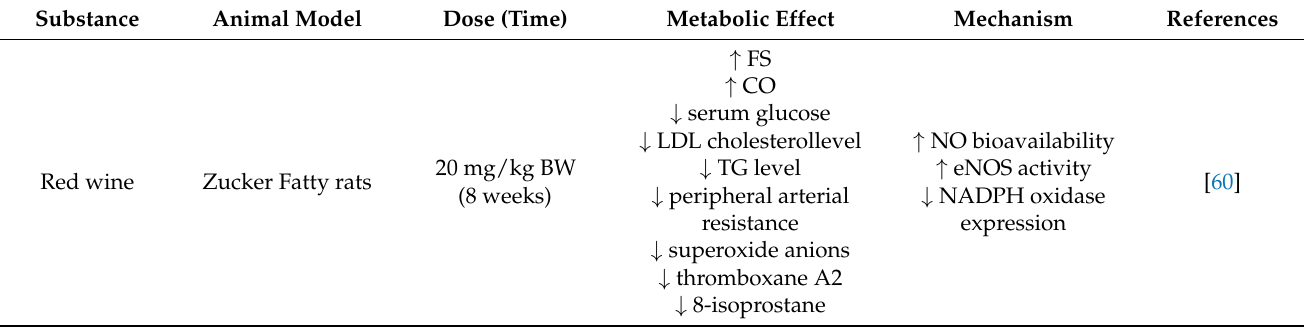
Table 2. The effects of selected polyphenolic compounds with promising bioactive potential on MetS.